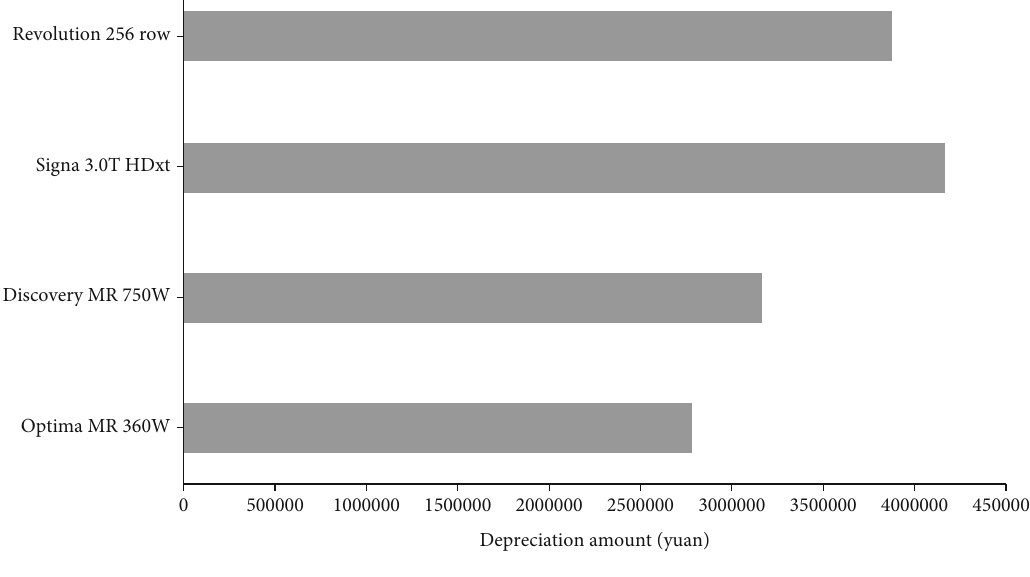
Figure 6: Annual depreciation amounts of 4 selected large medical equipment.